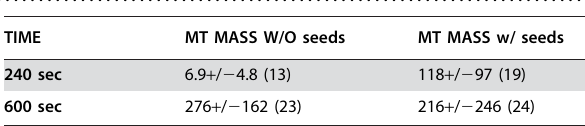
Quantification of RanQ69L-mediated MT production in meiotic Xenopus egg extract after 240 and 600 sec (MT mass in arbitrary units). The number of sample images used is given in parenthesis. In the right column, Taxol stabilized MT seeds (25 nM) were added together with RanQ69L. With Taxol stabilized MT seeds, aster formation is significantly faster and already after 240 sec the MT mass is close to saturation. This indicates that the MT seeds promote MT production, possible by stimulating autocatalytic MT production.